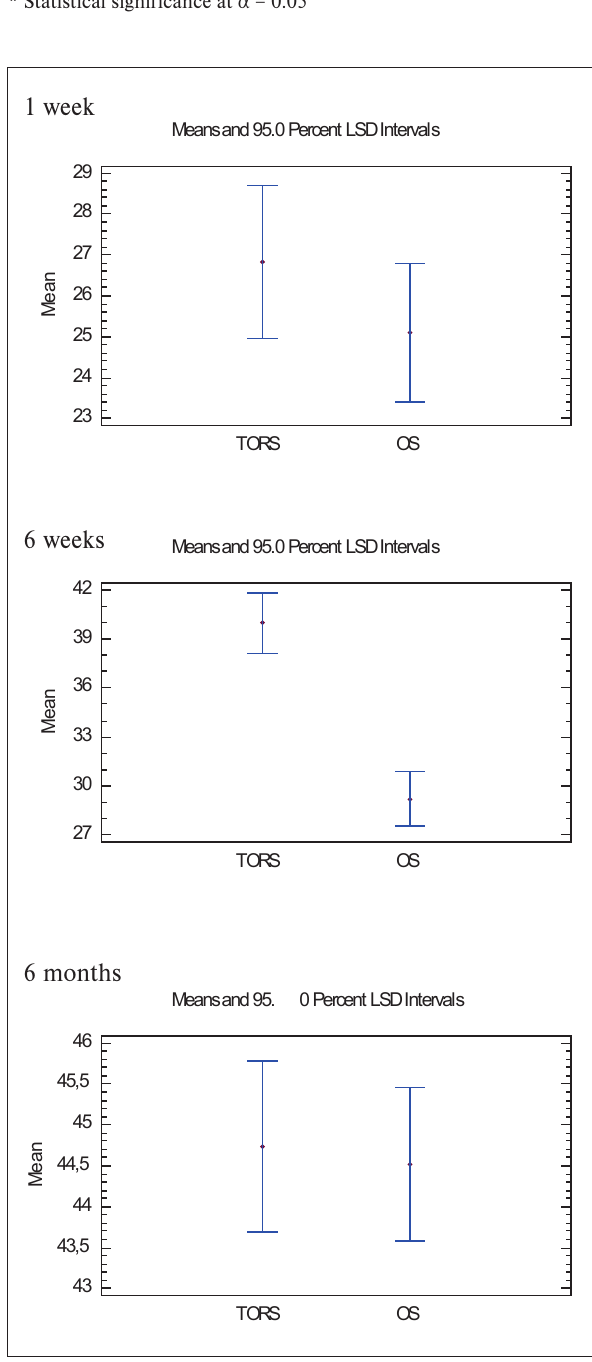
Fig. 4. pd scores in the selected intervals in Tors and